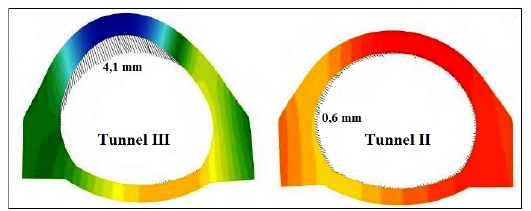
Figure 9. Deformation of Tunnels II and III in phase 500 ([2] –